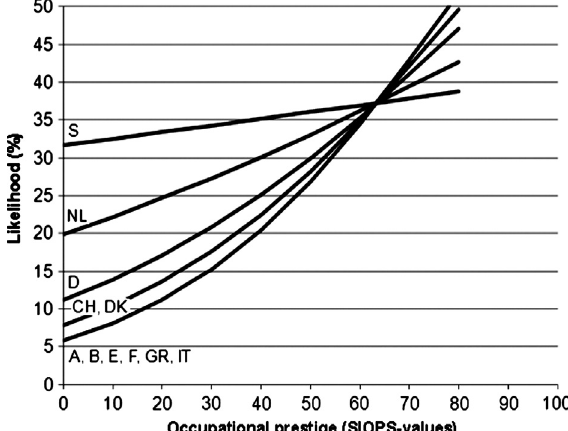
Figure 1. Occupational prestige and the likelihood that older men work for pay, per